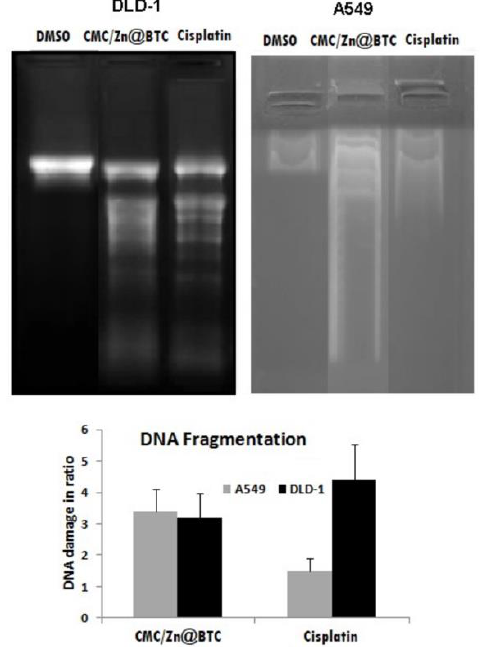
Figure 8. DNA damage effect of CMC/Zn@BTC.